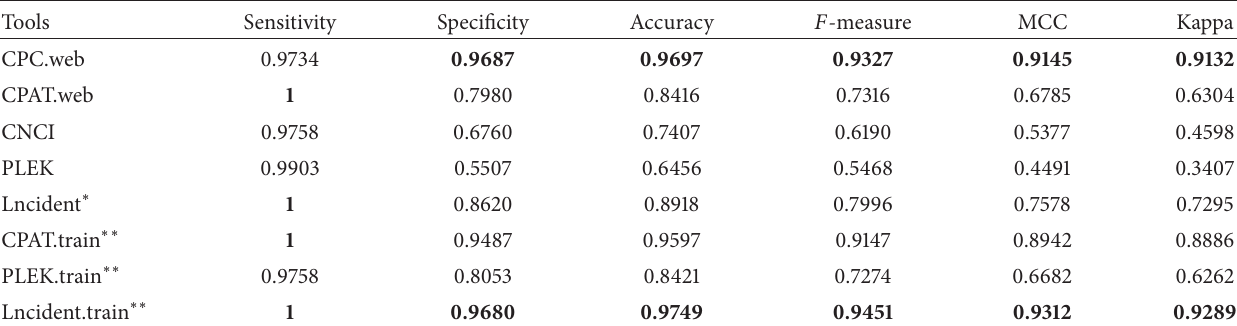
Table 3: Comparisons of S. cerevisiae